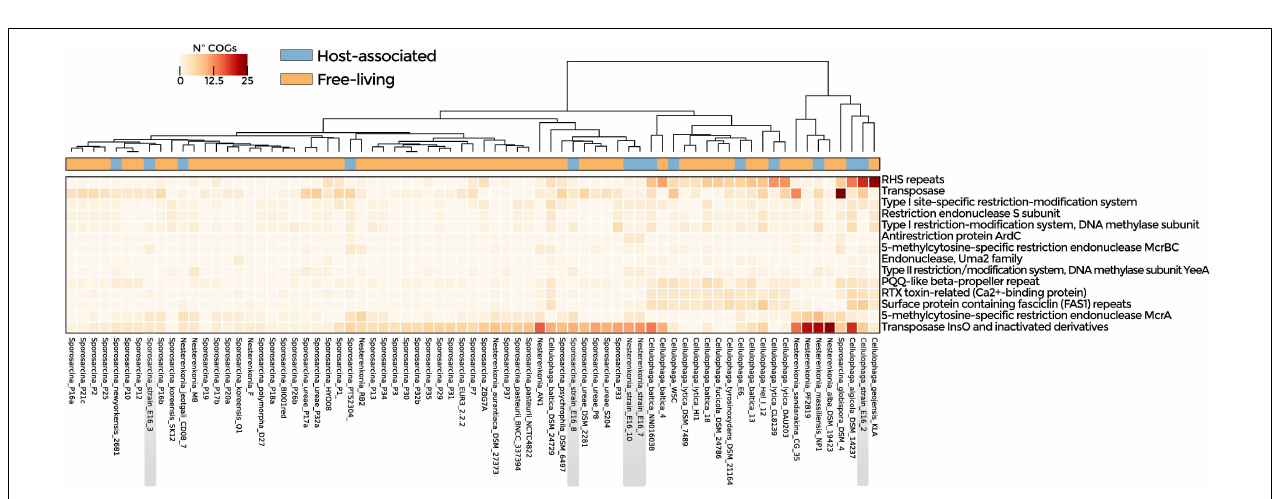
FIGURE 2 | Abundance of the sponge-associated bacterial genomes among sponge and seawater microbiomes, determined by metagenomic fragment recruitment and taxonomic classification of protein sequences. Dashed lines separate Antarctic sponge microbiomes, sponge microbiomes from other environments, and seawater microbiomes. Highlighted in gray is the metagenome from the Antarctic sponge host of the isolated strains. (A) Heatmap of fragment recruitment analysis. The scale bar indicates the percentage of recruited sequences per megabase pair. (B) Abundance of sequences classified at the protein level belonging to Sporosarcina , Cellulophaga , and Nesterenkonia genera.